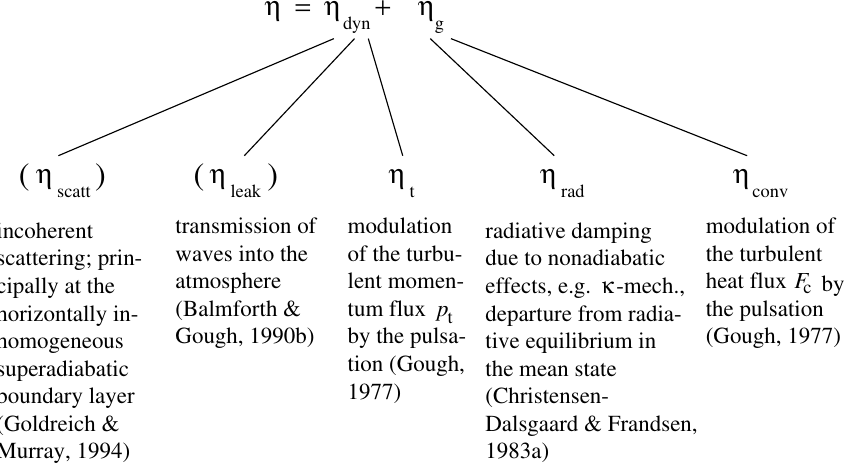
Figure 8: Physical processes contributing to the linear damping rate 𝜂 . They can be associated with the effects arising from the momentum balance ( 𝜂 dyn ) and from the thermal energy balance ( 𝜂 g ). The contributions 𝜂 scatt and 𝜂 leak are in parentheses because they have not been taken into account in the computations reported in this paper. The influence of Reynolds stresses on solar modes, contributing to 𝜂 t , has been treated by Goldreich and Keeley (1977) in the manner of a time-independent scalar turbulent viscosity. The width of the line in the Fourier power spectrum of the oscillations is influenced also by nonlinearities, both those coupling a mode to others (Kumar and Goldreich, 1989) and those intrinsic to the mode itself. Image reproduced with permission from Houdek et al. (1999a), copyright by